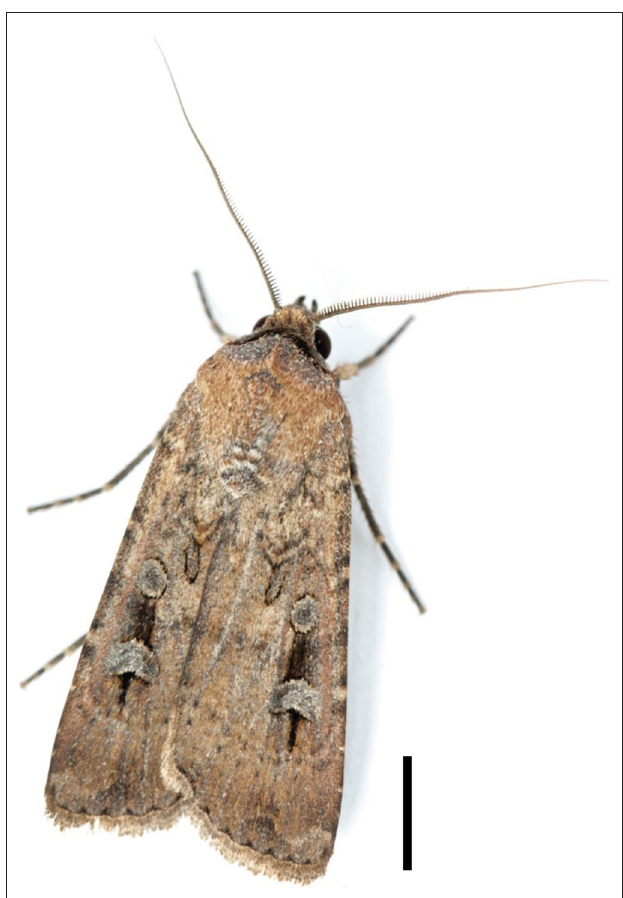
FIGURE 1 | The Australian Bogong moth Agrotis infusa (Boisduval, 1832). Scale bar = 5 mm. Reproduced with the kind permission of the photographer; Ajay Narendra, Macquarie University,